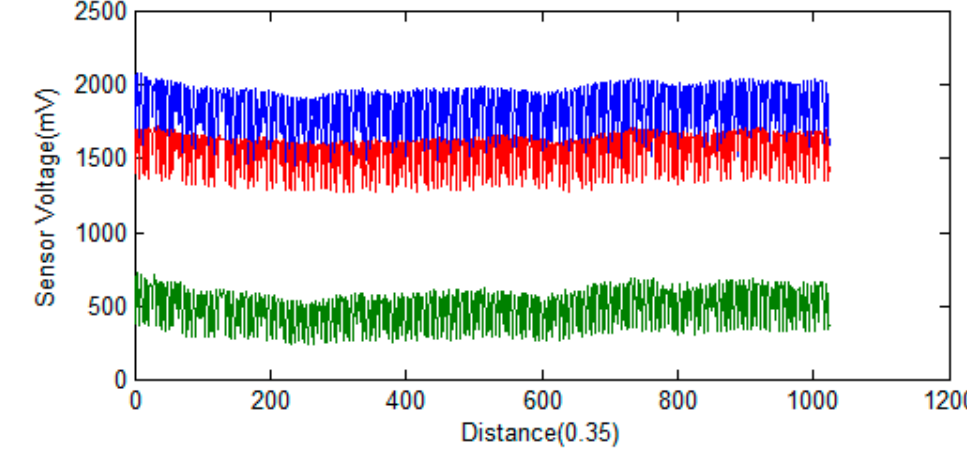
Figure 4. Three different sensor channels of raw MFL data.